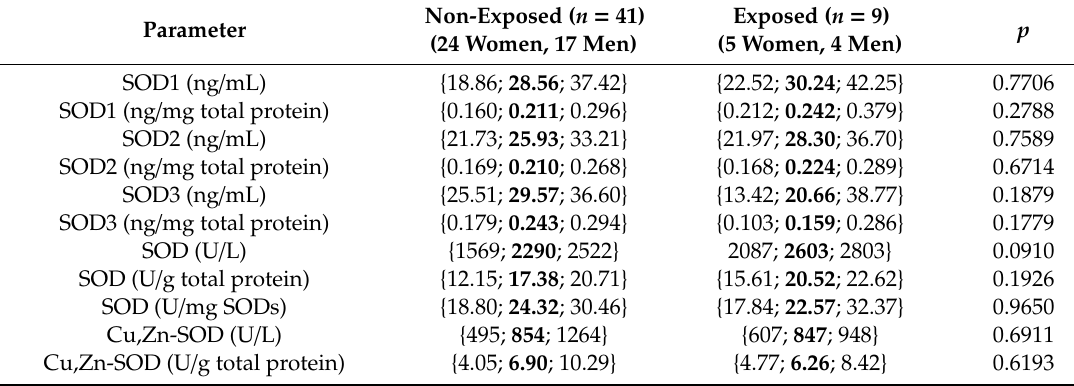
Table 4. Values of selected pro- and antioxidative parameters, and concentration of selected metals, in context of exposition to cigarette smoke, in non-obese